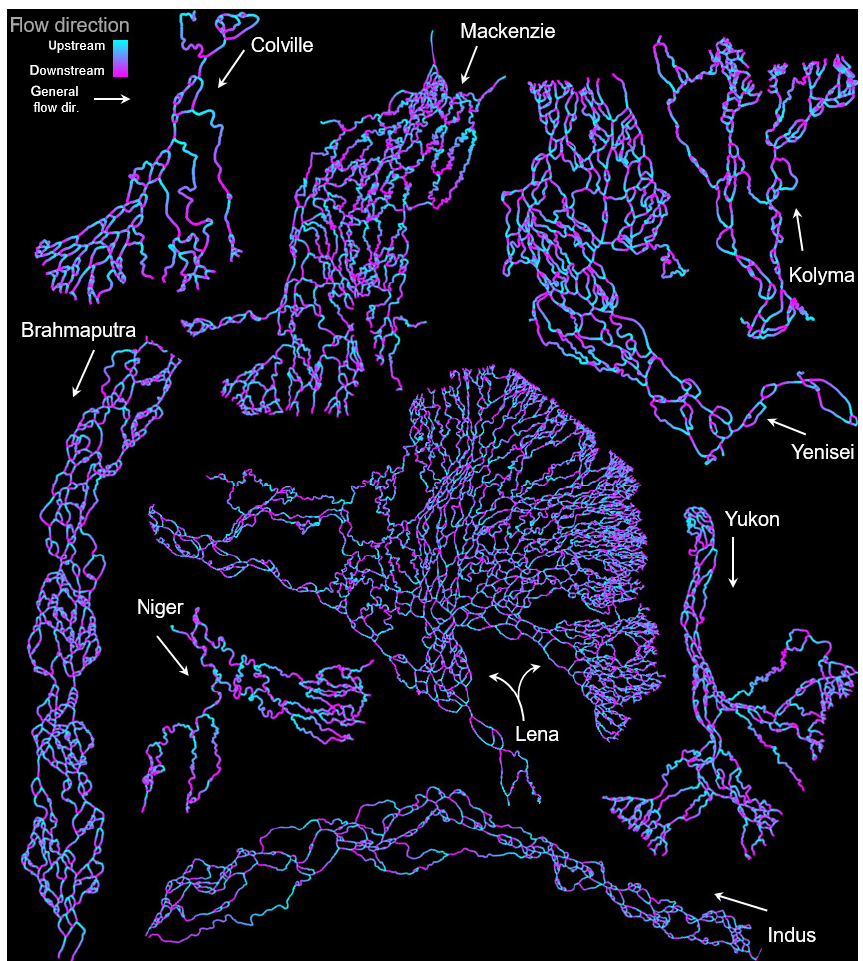
Figure 4. Flow directions for each channel network. The Brahmaputra and Indus rivers are cropped for improved visibility. White arrows denote the general flow direction for each